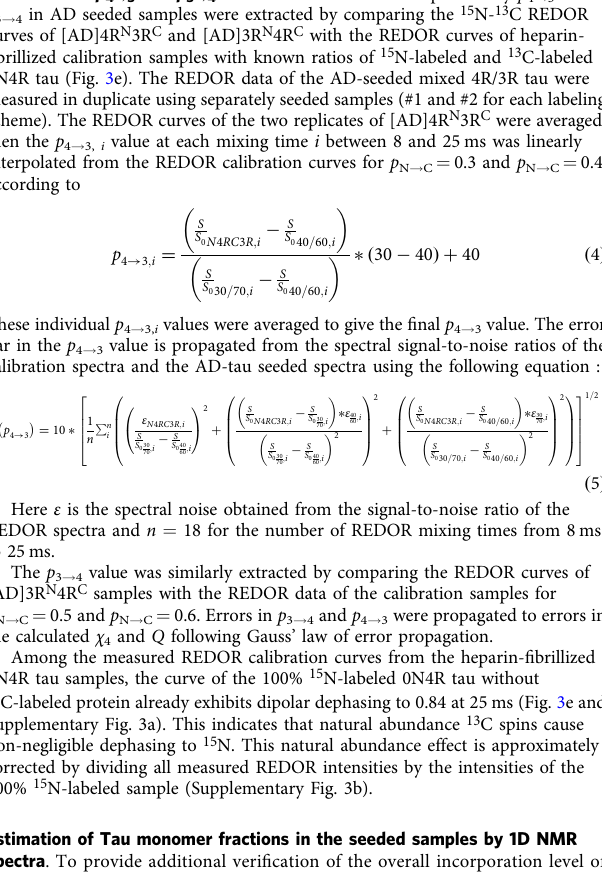
This second moment analysis ignores 13 C fi nite pulse effects, 13 C chemical shifts, and 13 C – 13 C dipolar couplings. The second moment analysis was conducted using Microsoft Excel 2021, with equation embedded in the Source Data. Supplementary Figure 3 shows that the SpinEvolution simulations and second- moment analysis produce REDOR dephasing curves that deviate in opposite ways from the measured curves after 13 C natural abundance correction. The 9-spin SpinEvolution simulations result in slightly higher S / S 0 values from the experimental values, whereas the 48-spin secondary moment analysis result in lower S / S 0 values than the experimental values (Supplementary Fig. 3f, h). The 9-spin second-moment analysis approaches the experimental data the closest (Supplementary Fig. 3g). The faster dephasing of the simulated REDOR curves with 48 nearest 13 C spins compared to dephasing by 9 13 C spins indicate